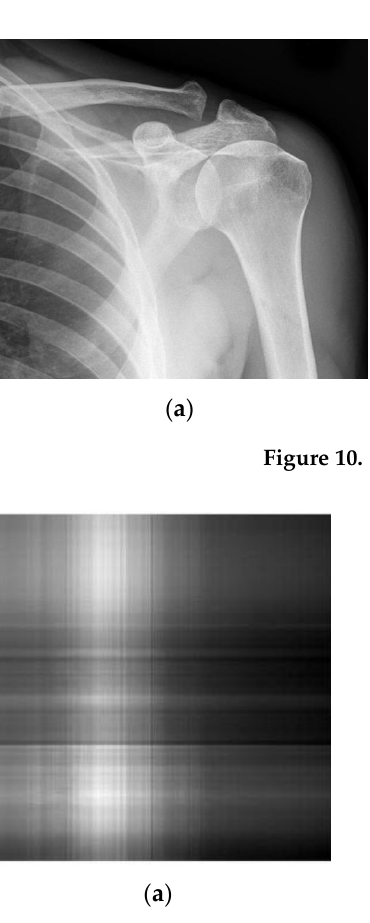
Figure 11. Output image: ( a ) Encrypted Image and ( b ) Histogram.